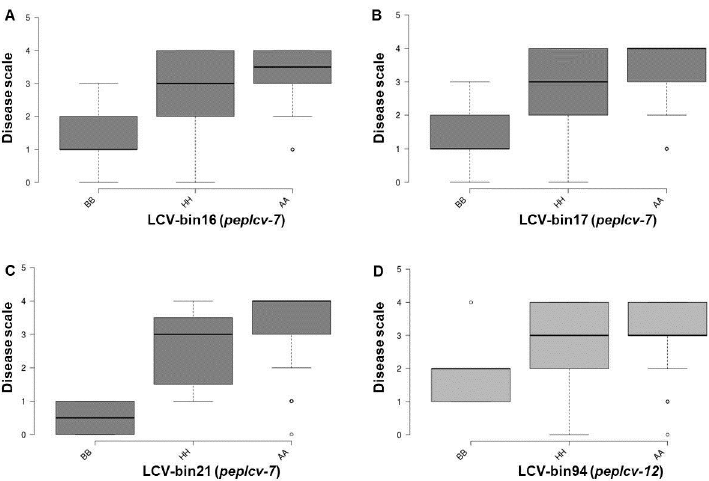
Fig 5. Box plots of tightly linked bins to QTLs from chromosome P7 and P12 of LP97-F 2 . A–C) LP97-F 2 grouped based on the tightly linked bin to QTL peplcv-7 against PepYLCV Indonesia strain. D) LP97-F 2 grouped based on the tightly linked bin to QTL peplcv-12 against PepYLCV Indonesia strain.